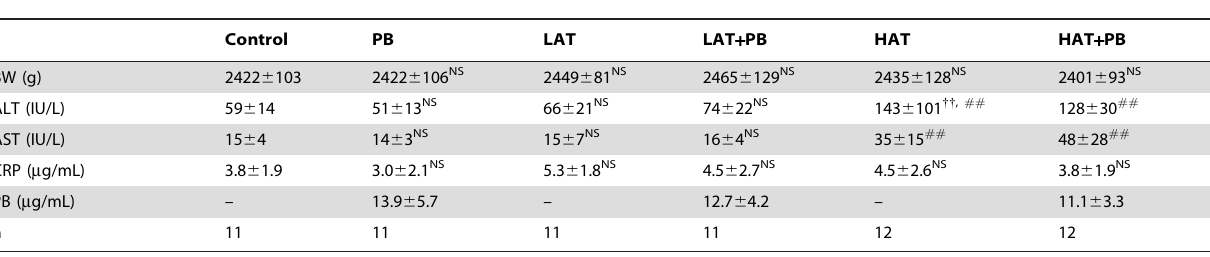
Table 1. Body Weight and Plasma